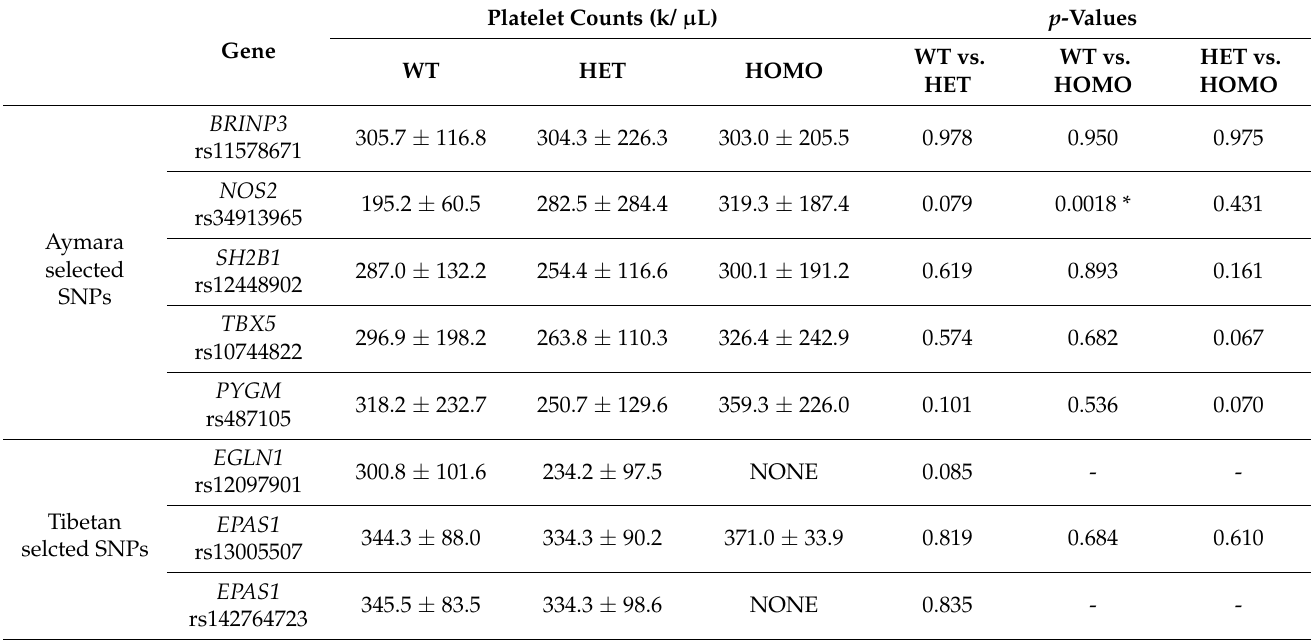
Table 5. Correlation of genotypes to platelet